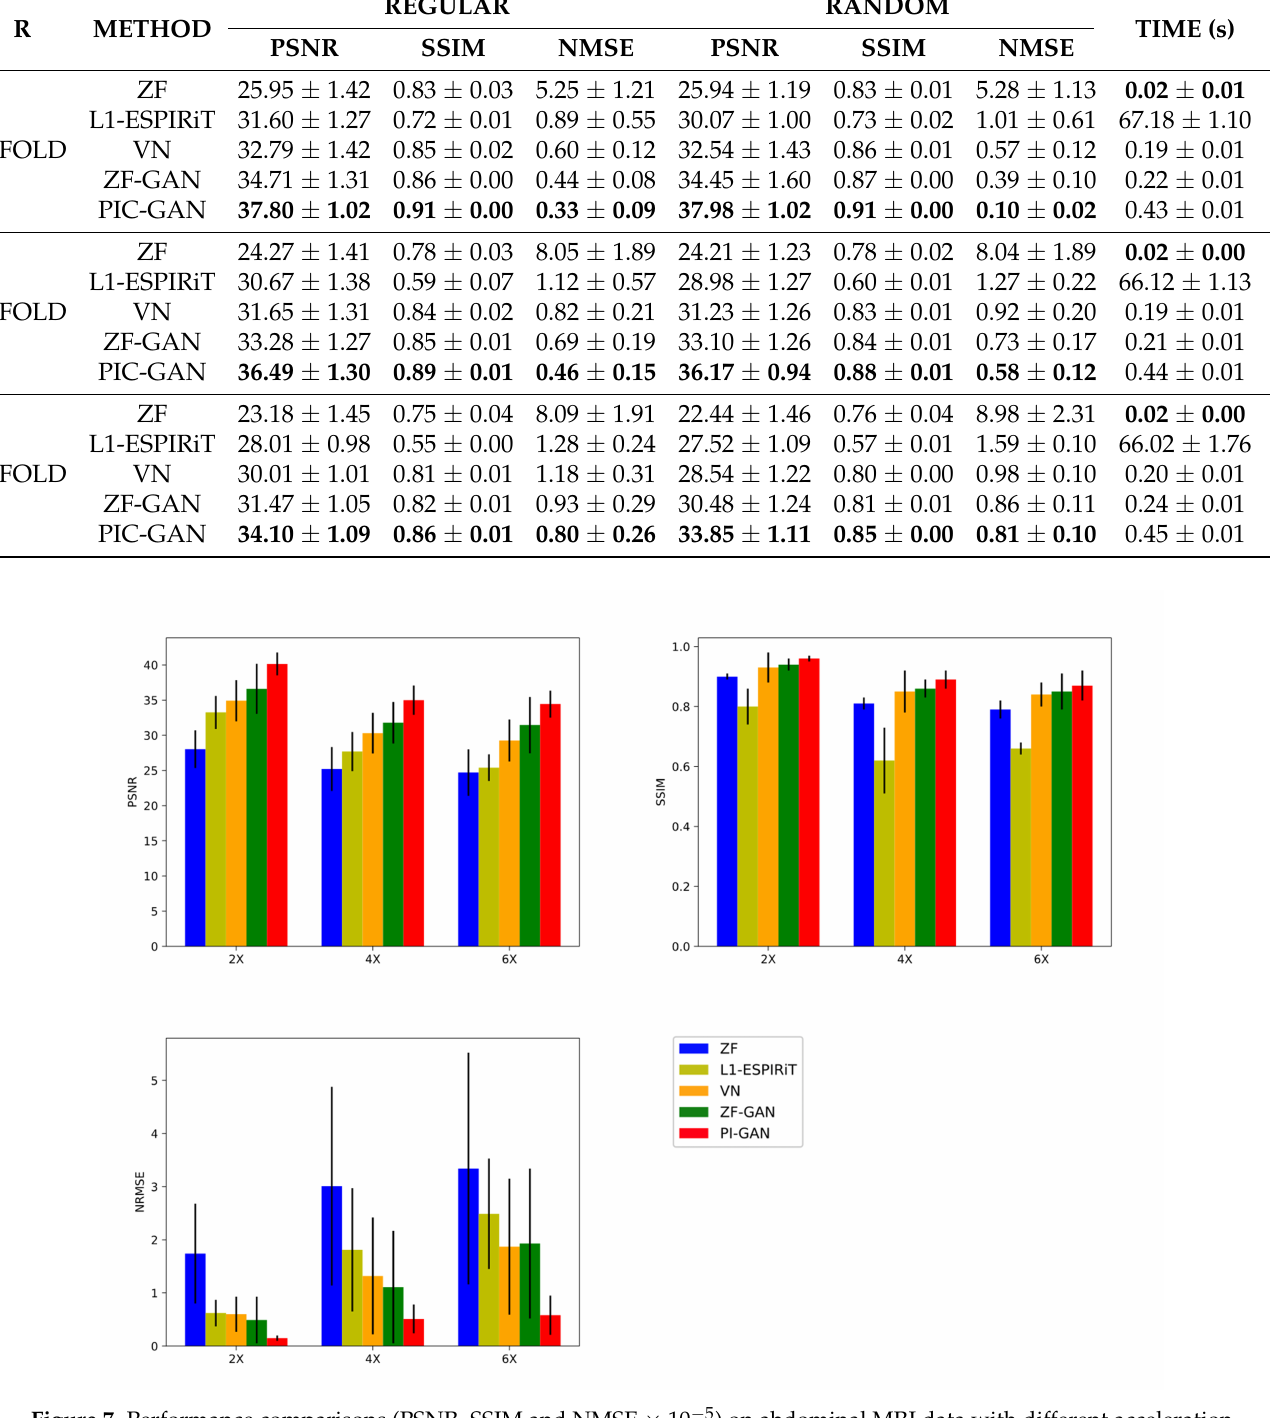
Figure 7. Performance comparisons (PSNR, SSIM and NMSE × 10 − 5 ) on abdominal MRI data with different acceleration factors. (GT: Ground truth. ZF: Zero-filled. L1-ESPIRiT: Sparsity-based parallel imaging. VN: Variational network. ZF-GAN: Conventional GAN with single-channel images as input PIC-GAN: Our proposed